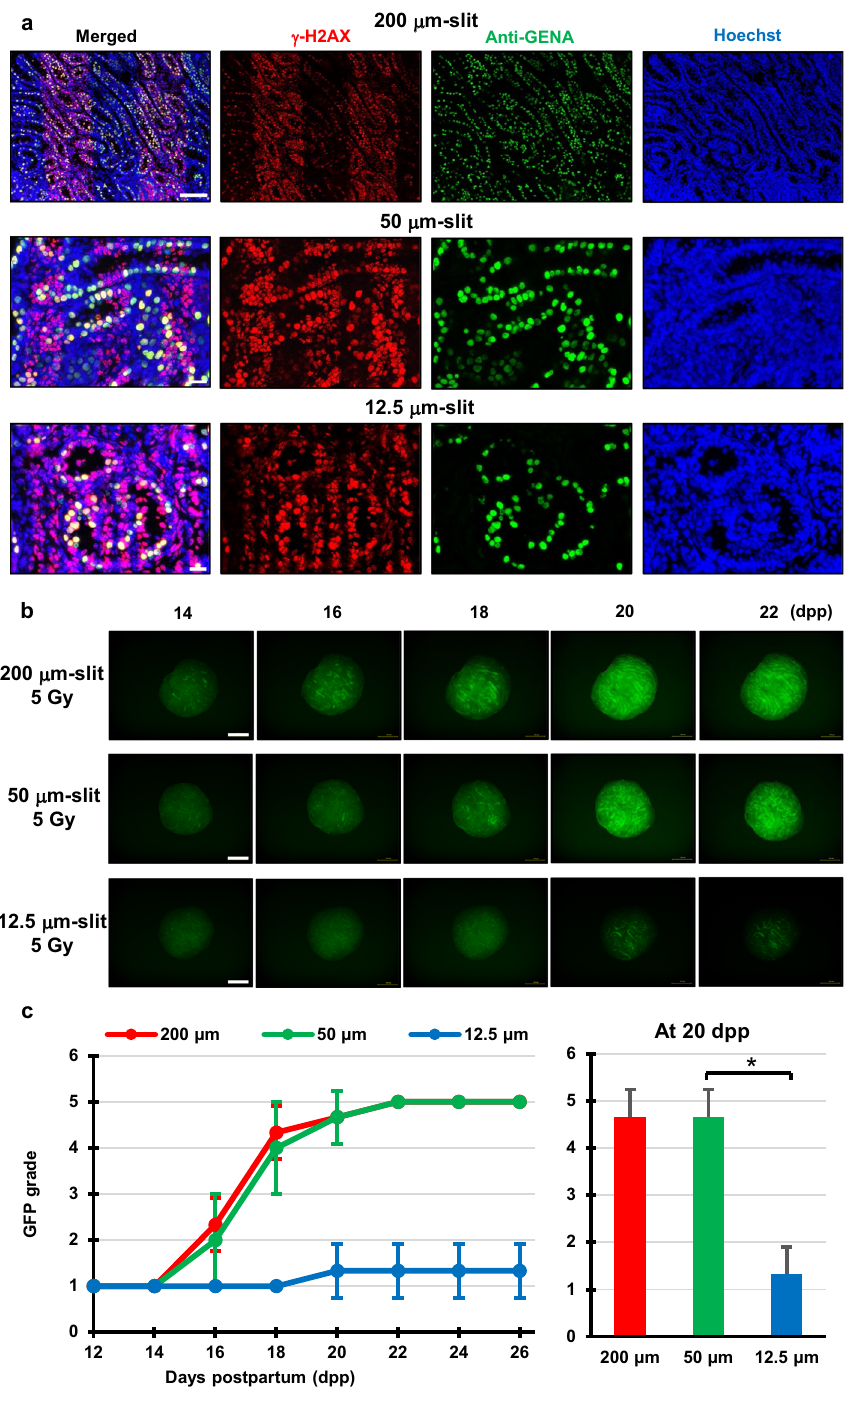
Figure 4. Difference of tissue-sparing effect between 200, 50, and 12.5 μ m-slit radiation. ( a ) Immunohistochemical images of ex vivo testes culture tissues 1 h after 10 Gy 200, 50 and 12.5 μ m-slit X-ray microbeam irradiation. Staining for γ -H2AX, Anti-GENA (anti-germ cell-specific antigen antibody), and Hoechst (for DNA) is shown as red, green, and blue, respectively. Scale bars, 100 μ m (upper); 20 μ m (middle and lower). ( b ) Representative images showing Acr-GFP expression in single cultures following 0 Gy (control), 5 Gy 200, 50 and 12.5 μ m-slit (50%), and 2.5 Gy uniform X-ray irradiation (100%) obtained at 14, 16, 18, 20 and 22 dpp. Scale bars, 500 μ m. ( c ) Chronological Acr-GFP expression changes after the 5 Gy 200, 50 and 12.5 μ m-slit (50%) X-ray irradiation. A minimum of three tissue samples each from different donor mice were used for each experiment. Data represent the mean Acr-GFP expression ± SD. Asterisk indicates P <